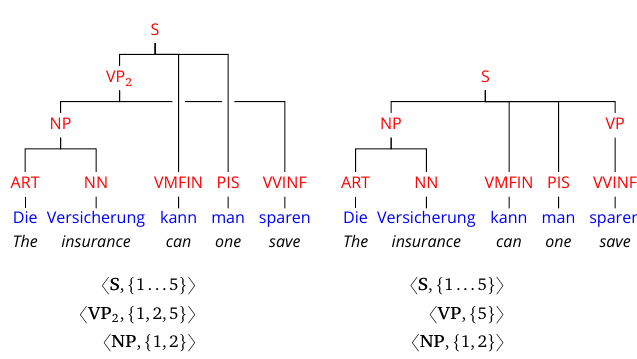
Bracketings from a tree with and without discontinuous